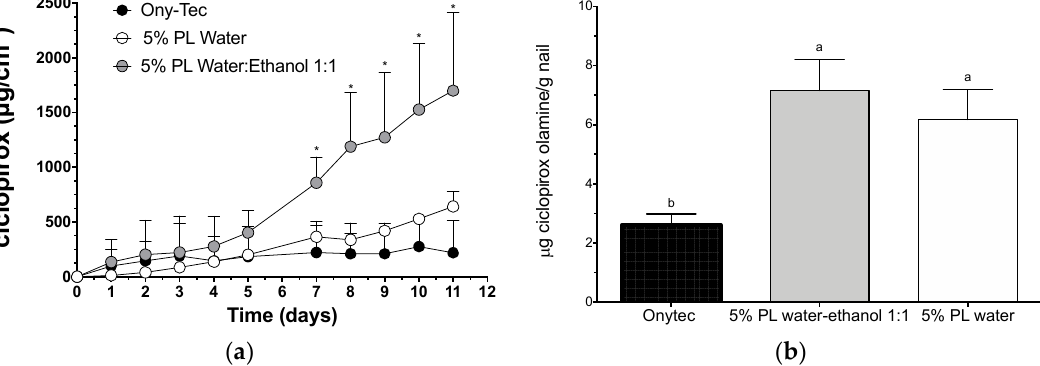
Figure 8. ( a ) Cumulative permeation of ciclopirox olamine across human nail (mean ± SD, n = 3). ( b ) amount of drug recovered from human nail clippings after an eleven days permeation study. The lacquers tested contained 5% Poloxamer 407 and either water or a 1:1 water:ethanol mixture. Onytec ® was used a reference. Stars indicates significant differences with the other lacquers (two-way ANOVA, Tukey post-hoc test, α < 0.05) and same letter indicates homogeneous groups (one-way ANOVA, Tukey post-hoc test, α < 0.05).